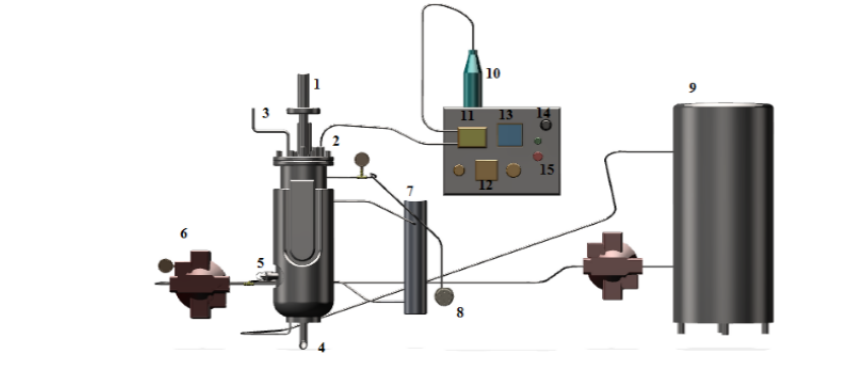
Figure 1. Schematic diagram for the double jacket anaerobic bio-reactor.